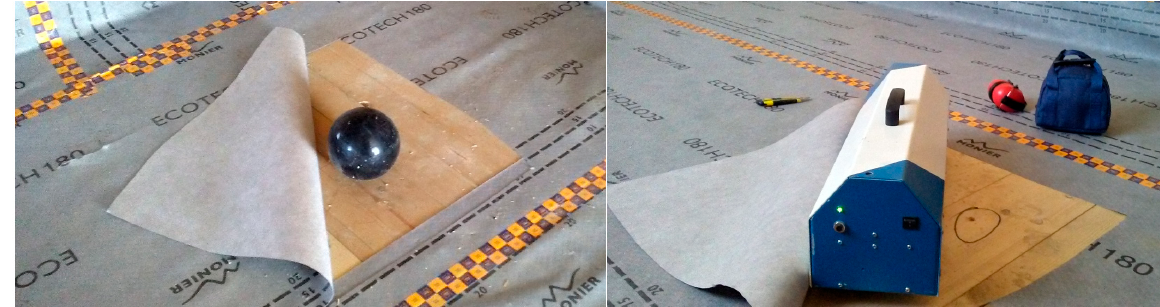
Figure 7. Tapping machine and rubber ball used to test the impact noise of CLT floors.